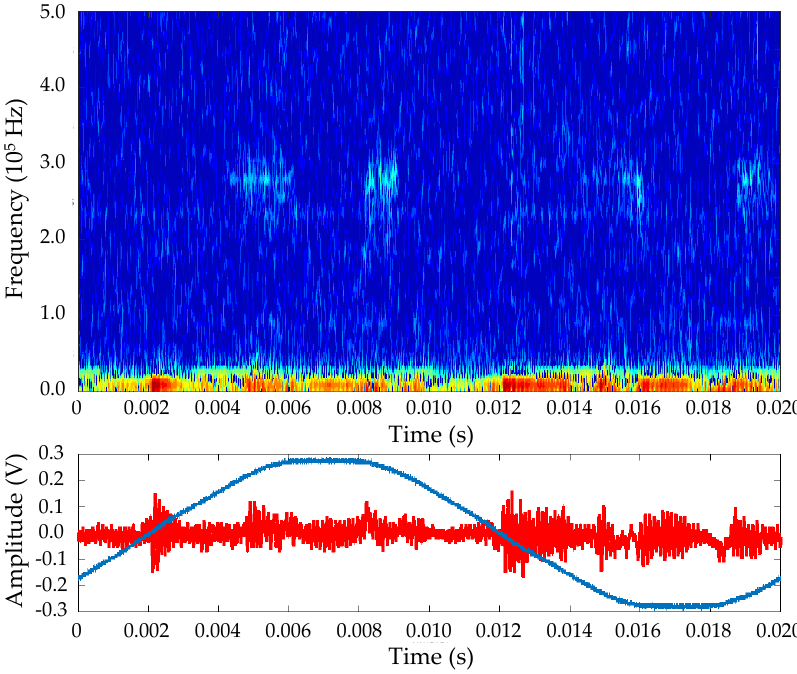
Figure 13. Pseudo Wigner-Ville transform analysis for the rural site in the time-frequency domain.